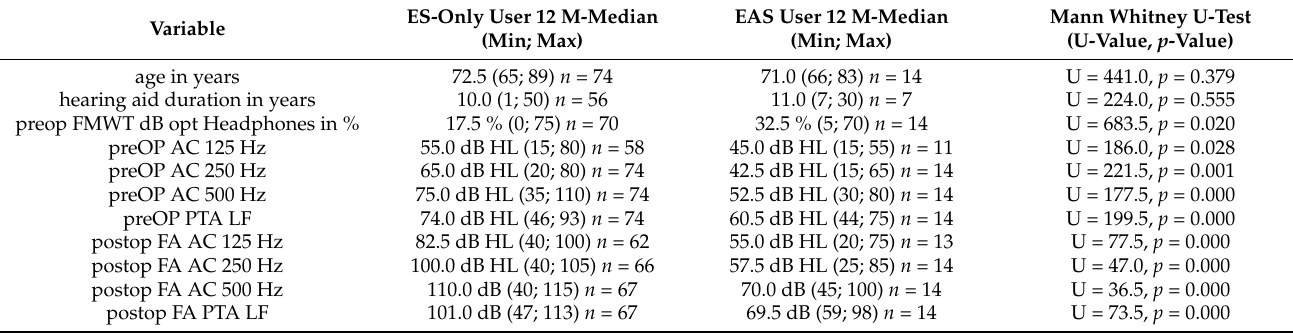
Table 3. Comparison of ES-only users and EAS users at 12-months regarding age at implantation, hearing aid duration, and preoperative FMWT results unaided at optimum dB SPL when tested with headphones and preoperative and 12-months post-activation at hearing levels for 125 Hz, 250 Hz, and low-frequency PTA median, minimum and maximum.